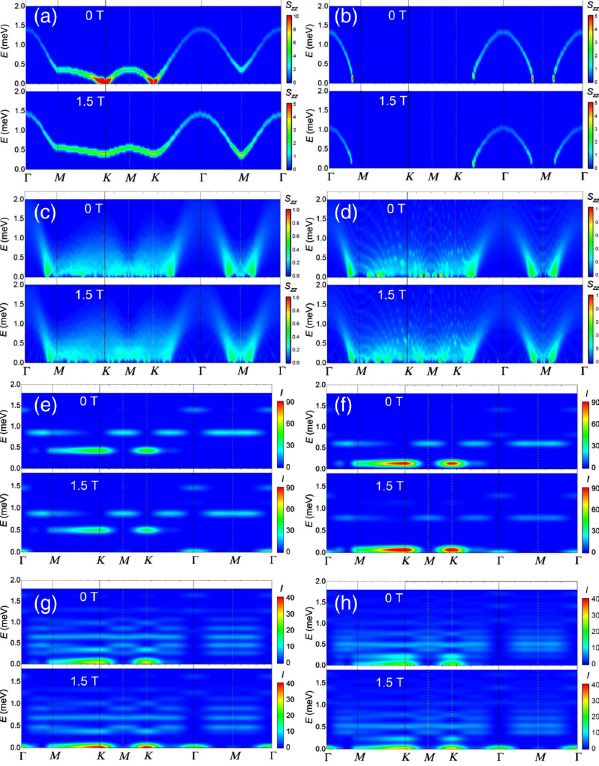
14. Calculated spin-wave excitations by Spinw at the longitudinal fields of 0 T and 1.5 T, using (a) model 1, (b) model 2, (c) model 3, and (d) model 4. Calculated INS spectra by the ED using the 9-site cluster with PBC at the longitudinal fields of 0 T and 1.5 T, at 50 mK, using (e) model 1, (f) model 2, (g) model 3, and (h) model 4 [see Eq. (E5)]. The instrumental resolution of 4 . 8 meV, and the linear Q -scan ranges 0.114 meV is used at E i ¼ are kept the same as Ref.